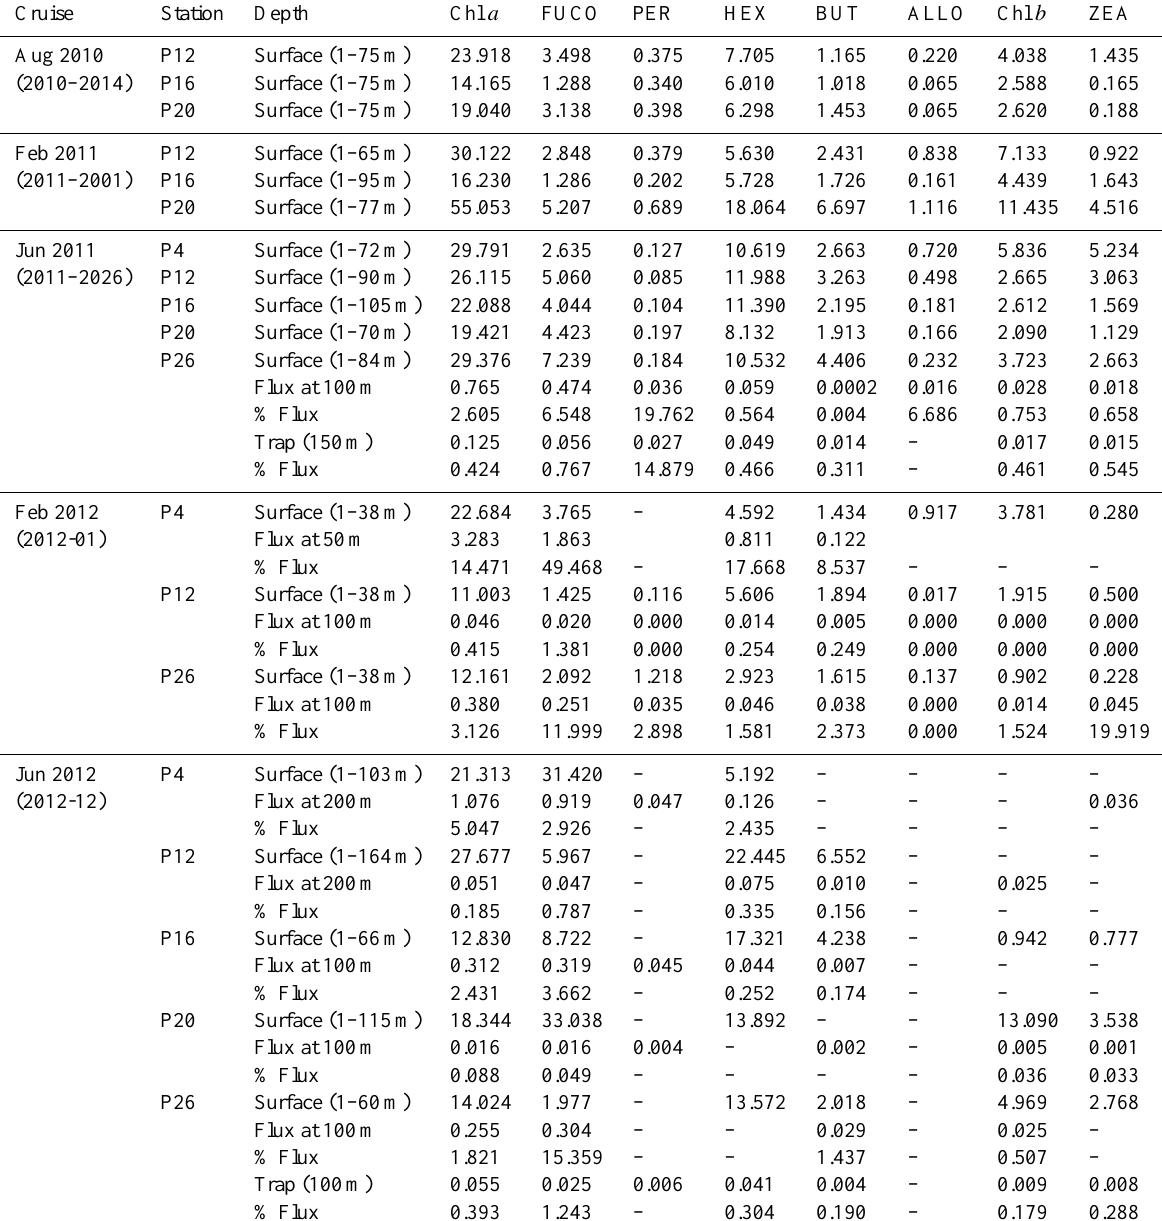
Table 4. Chl a and indicator pigment standing stocks determined by integrating small volume pigment concentrations (determined by HPLC) across the photic zone, pigment fluxes ( 234 Th- and PITS-derived) measured at the base of the photic zone, and pigment loss rates, or the percent of the surface concentration represented by those fluxes. Pigment standing stocks are in mgm − 2 and pigment fluxes are in mgm − 2 d − 1